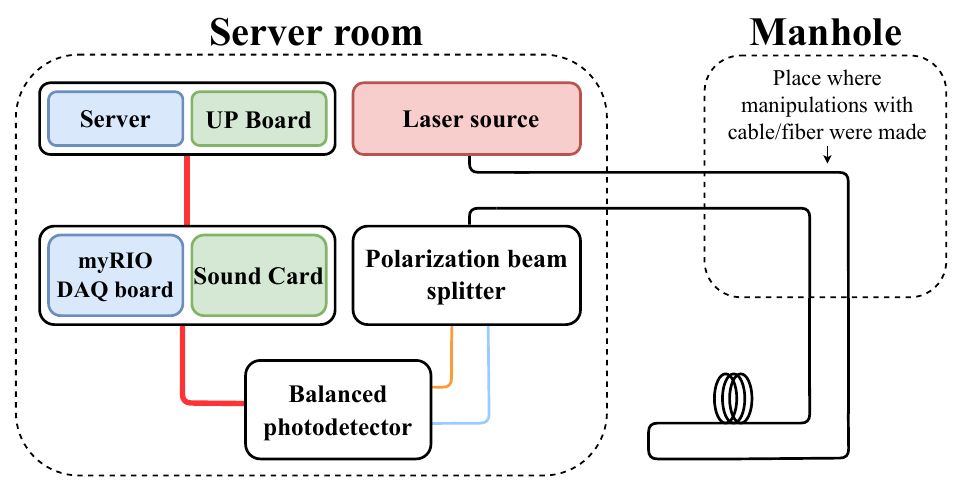
Figure 3. Schematic of the experimental setup.